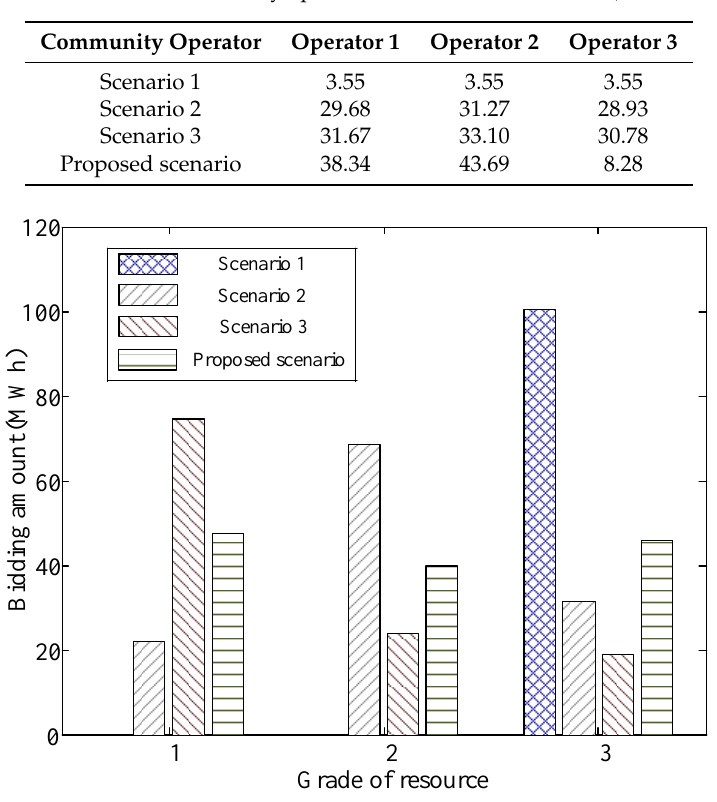
Table 3. Profit of 3 community operators for different scenarios ( × 10 3 RMB).